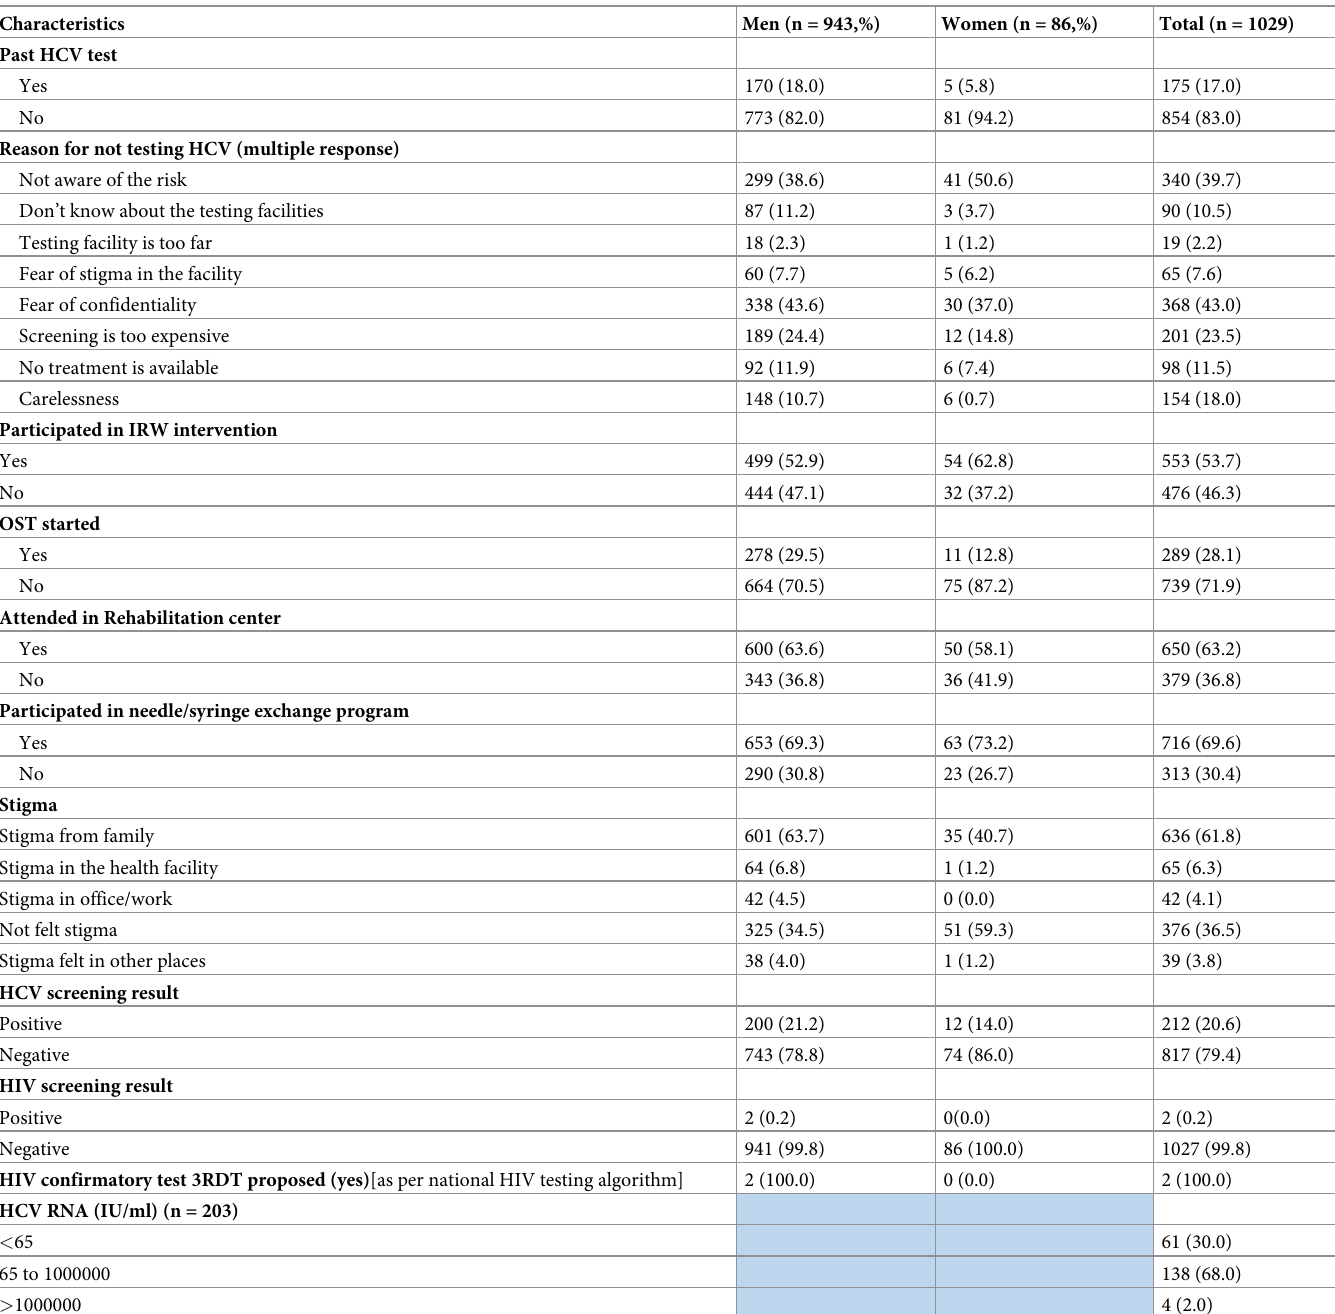
Table 3. Past testing, prevention, stigma, and current testing results by gender.